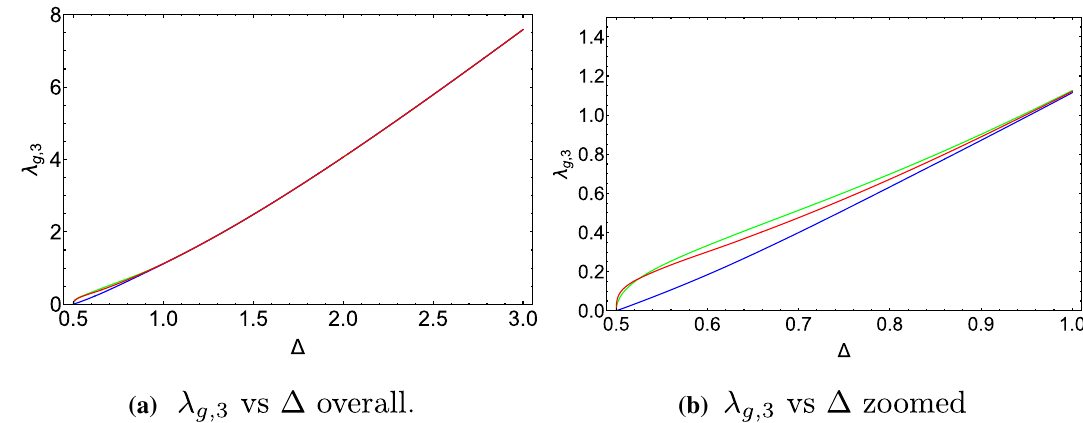
Fig. 1 a λ g , 3 vs (cid:2) : green, blue and red colored curves for λ g , 3 are obtained by letting d N = 0, with N = 30 , 31 , 32 respectively. There are three branches in 1 / 2 < (cid:2) < 1. And such branches merge for (cid:2) ≥ 1. b Zoom in of figure a for the regime 1 / 2 < (cid:2) < 1